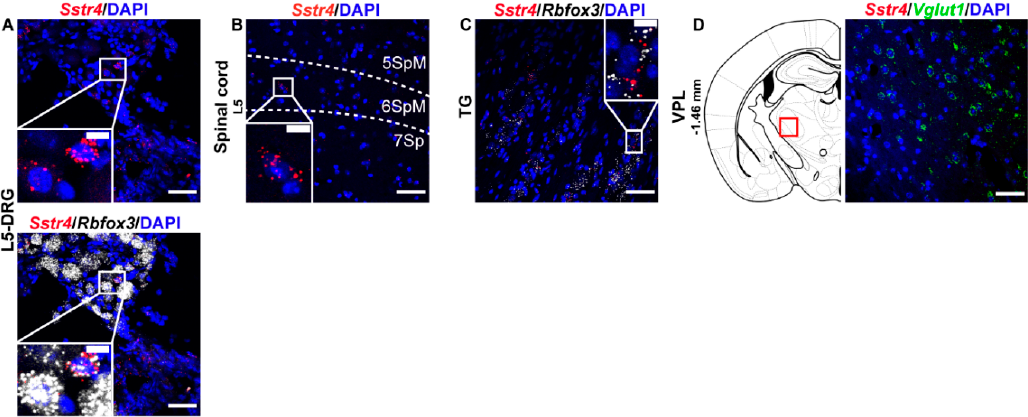
Figure 2. Representative Sstr4 mRNA expression counterstained with DAPI in the primary nociceptive spinothalamic system in WT mice. Sstr4 mRNA (red, upper and lower panel) co-localized with Rbfox3 mRNA (NeuN, white, lower panel) and are shown in the L5 dorsal root ganglion (DRG) ( A ). Sstr4 mRNA (red) is shown in the in the laminae V-VII of the spinal cord of L4–L6 (( B )), in the trigeminal ganglion (TG, ( C )) co-localized with Rbfox3 mRNA (NeuN, white), and in the ventral posterolateral thalamic nucleus (VPL, Bregma − 1.46 mm, ( D )) co-localized with Vglut1 (green) mRNA. Note that Sstr4 cannot be detected in VPL area. N = 3. Scale bar 50 µ m, inset scale bar: 10 µ m.